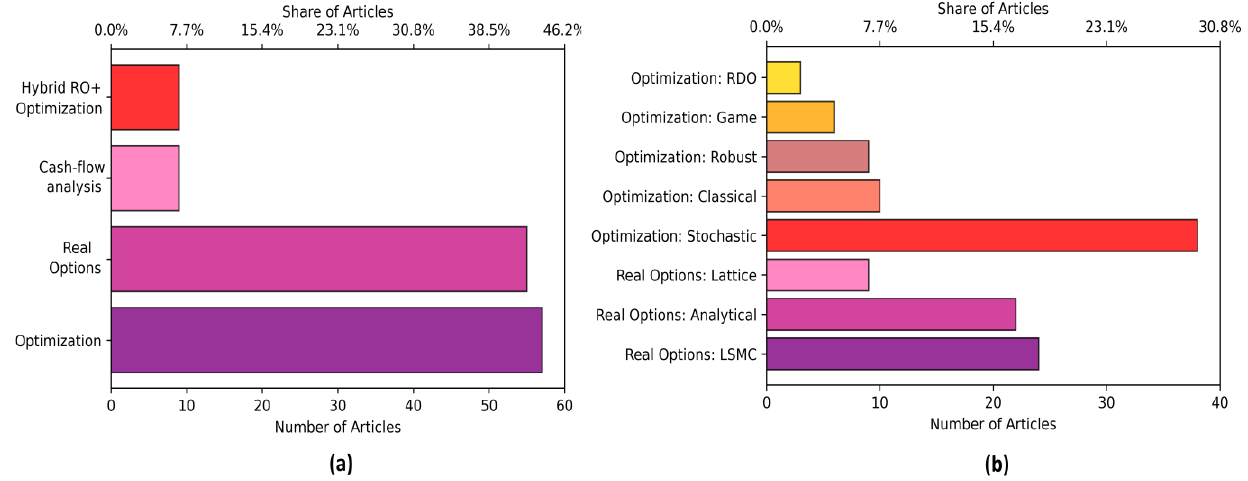
Figure 7. ( a ) Number and share of articles in the pool that consider each problem formulation. Each article belongs to one of these categories. ( b ) Breakdown of optimization and ROA